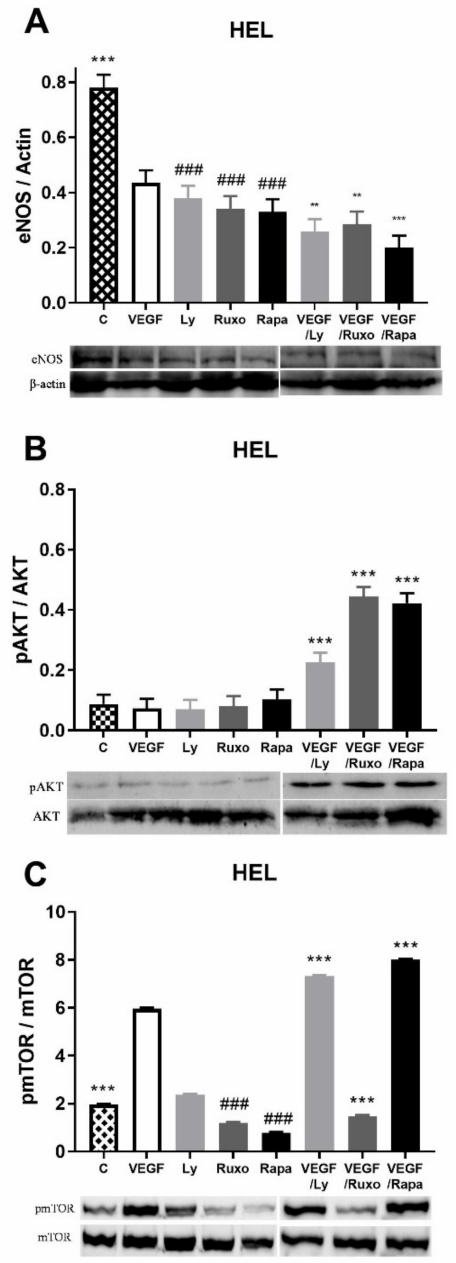
Figure 4. Vascular endothelial growth factor (VEGF) induction of angiogenic factors and related signalling pathways in JAK2 V617F positive human erythroleukemic cells (HEL). Densitometry revealed protein expression determined by Western blotting and presented as a ratio to Actin of total protein levels. The HEL cells were treated for 1 h with 10 µ g/mL VEGF with or without 1 µ M JAK1/2 inhibitor Ruxolitinib, 5 µ M PI3K inhibitor LY294002 and 100 ng/mL mTOR inhibitor Rapamycin and levels of ( A ) endothelial nitric oxide synthase (eNOS), ( B ) phospho AKT, and ( C ) phospho mTOR were determined. Values are mean ± SEM ( n = 3). ** p < 0.01, *** p < 0.001 vs. VEGF; ### p < 0.001 vs.